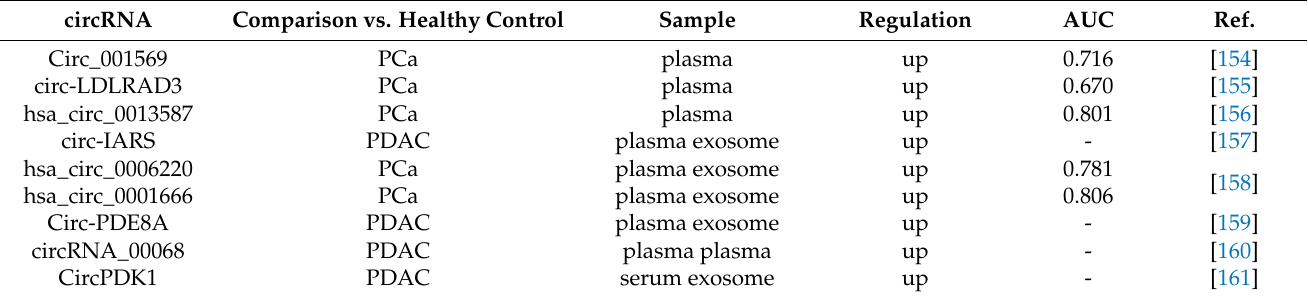
Table 3. Summary of promising circular RNAs for diagnosis of pancreatic cancer. circRNA Comparison vs. Healthy Control Sample Regulation AUC